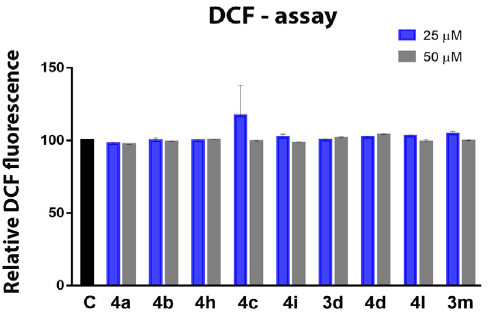
Figure 3. Results of the DCF assay performed on SH-SY5Y treated with representative compounds at 25 and 50 µM.